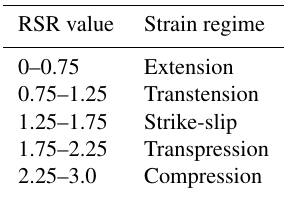
Table 2. Regime stress ratio (RSR) values and corresponding inter-